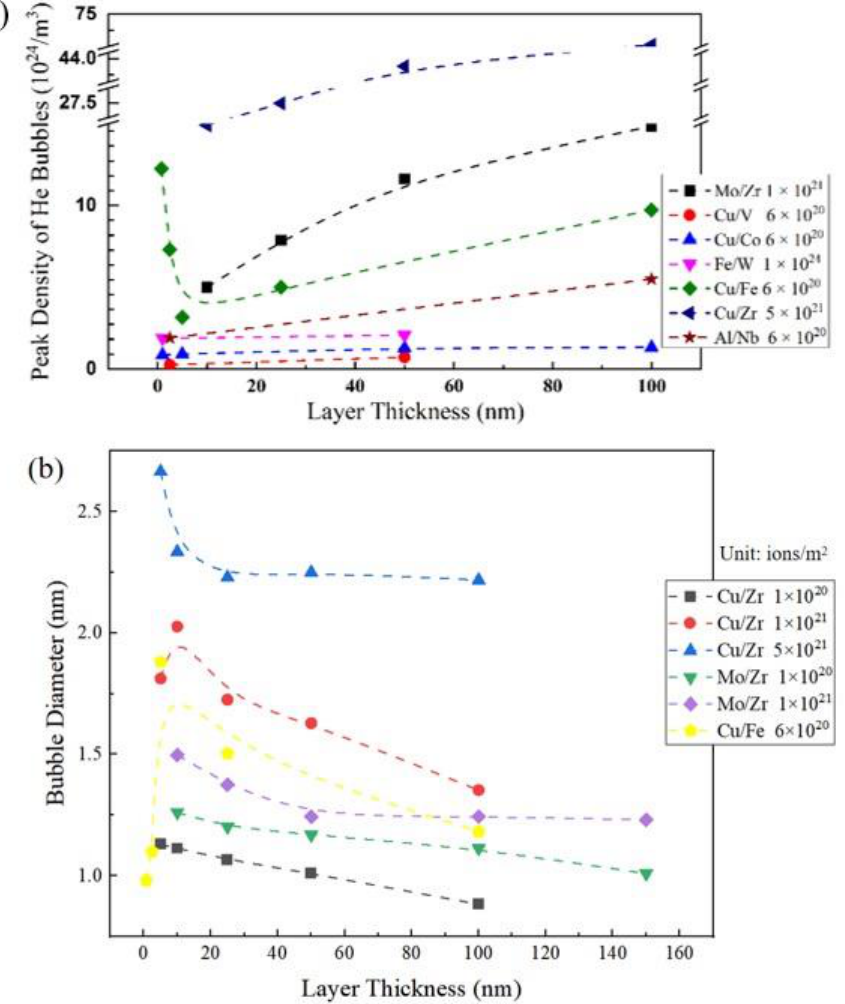
Figure 11. The relationship between ( a ) the density and ( b ) diameter of He bubbles; the layer thickness of Mo/Zr [92], Cu/V [5], Cu/Fe [56], Cu/Co [76], Cu/Zr [84], and Fe/W [3]; and Al/Nb [57] multilayer films after He irradiation with different fluences.